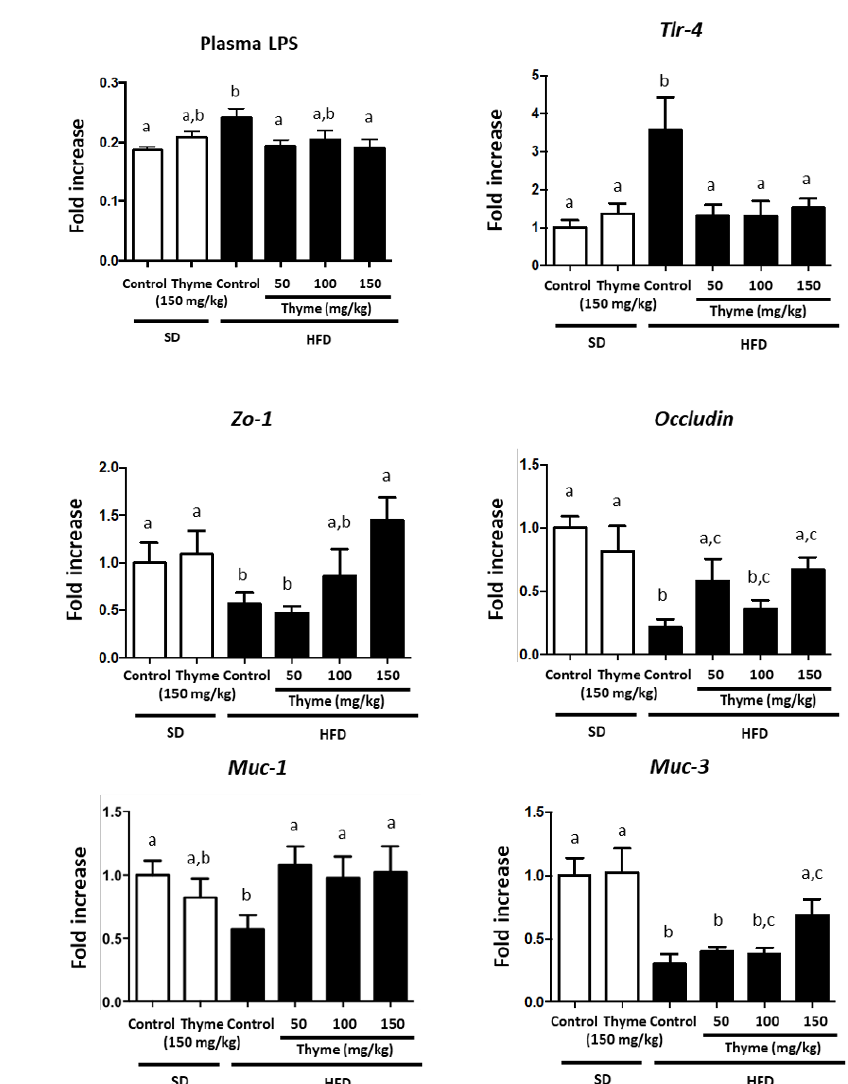
Figure 8. Effects of Thyme extract administration on: ( A ) plasma LPS levels and gene expression of TLR4 in liver and ( B ) markers of intestinal barrier integrity Zo-1 , Occludin , Muc-1 and Muc-3. Data are expressed as means ± SEM ( n = 10). Groups with different letters statistically differ ( p < 0.05).